Question: Reading the figure, is the described quantity rising or falling?
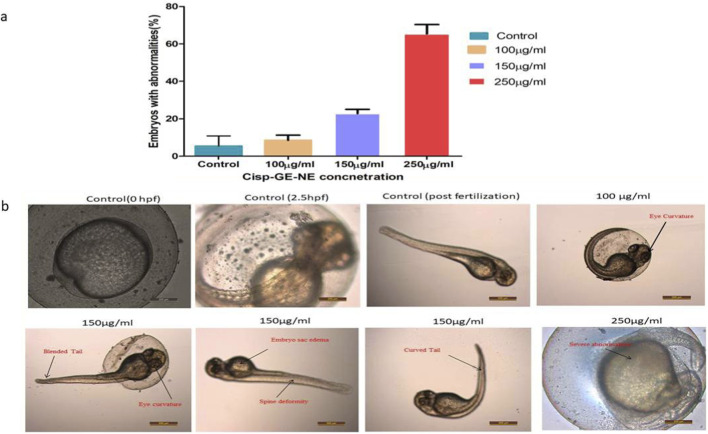
Answer: increasing